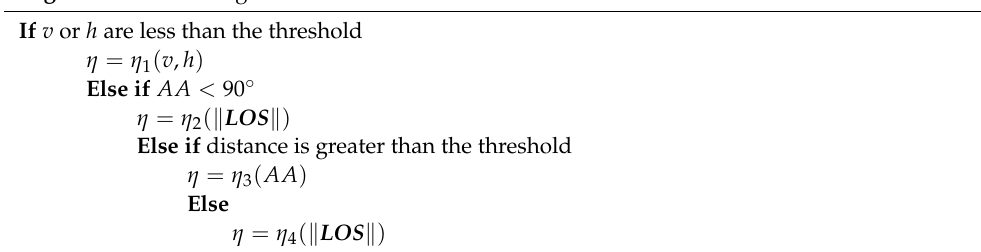
Algorithm 1 Switching Process of an Air Combat Situation